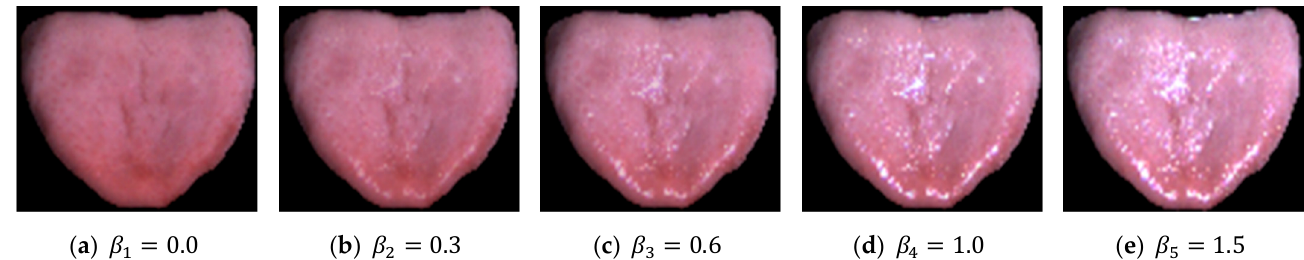
Figure 5. Five levels of gloss modulation using the modulation coefficient β i .